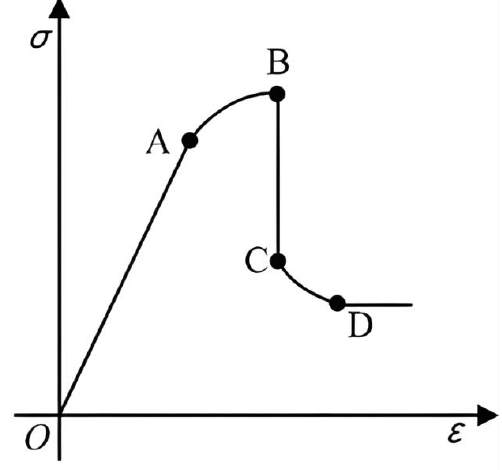
Figure 5. Tensile stress–strain curve of brittle materials.